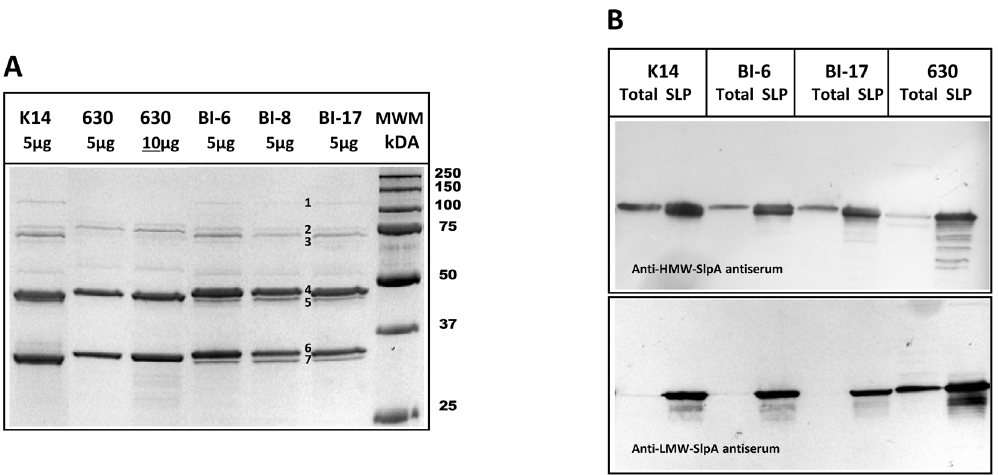
Figure 5. C.difficile surface-layer protein profiles and antigen cross-reactivity. Panel A. Extracted surface-layer protein (SLP) profiles of various C. difficile strains. Numbers indicate band identities by mass spectrometry: 1: Cwp20; 2: Cwp84; 3: Cell-wall protein; 4: S-layer protein, SlpA; 5: S-layer protein, SlpA; 6: S-layer protein, SlpA; 7: S-layer protein, SlpA. Panel B: Western blot analyses of SLP preparations from C. difficile strains. For all C. difficile strains tested, 30 m g of total soluble and 5 m g of SLP preparations were electrophoresed; antisera were used at a 1:100,000 dilution.